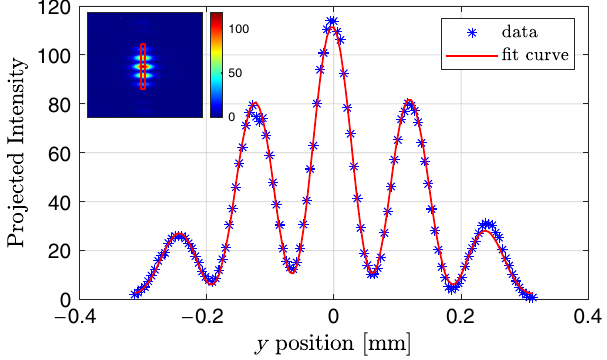
FIG. 8. Beam size measurement for a low current beam at the Duke storage ring. The main plot shows the projected vertical intensity distribution of the image. The blue stars are the average value of the image intensity in the selected area shown as a red rectangle in the inserted image and the red solid line is the fit curve using Eq. (17). The inset shows the average image of 22 images taken using a CMOS camera with the same exposure time (1s) and a constant gain with the background subtracted. The beam current is determined to be 12 . 5 (cid:3) 0 . 2 μ A using an imaging technique, and the beam size is measured to be 14 . 6 (cid:3) 0 . 4 μ m. The storage ring is operated at 562 MeV in a multibunch mode